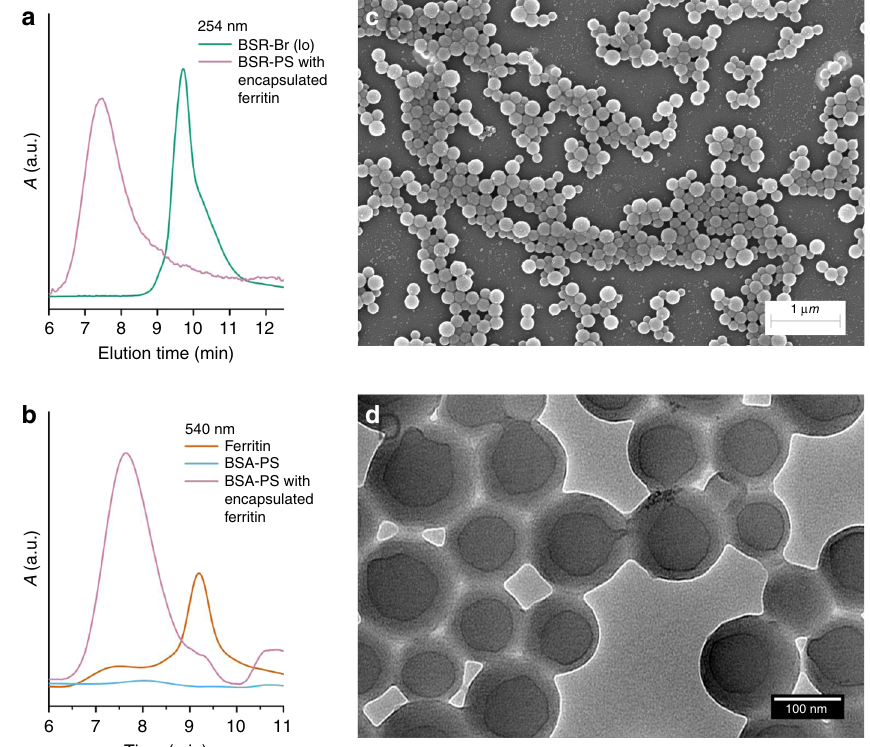
Fig. 5 BSA-PS nanocarriers — ferritin encapsulation. SEC traces at a 254 nm and b 540 nm. c SEM and d TEM micrographs of BSA-PS prepared in the presence of